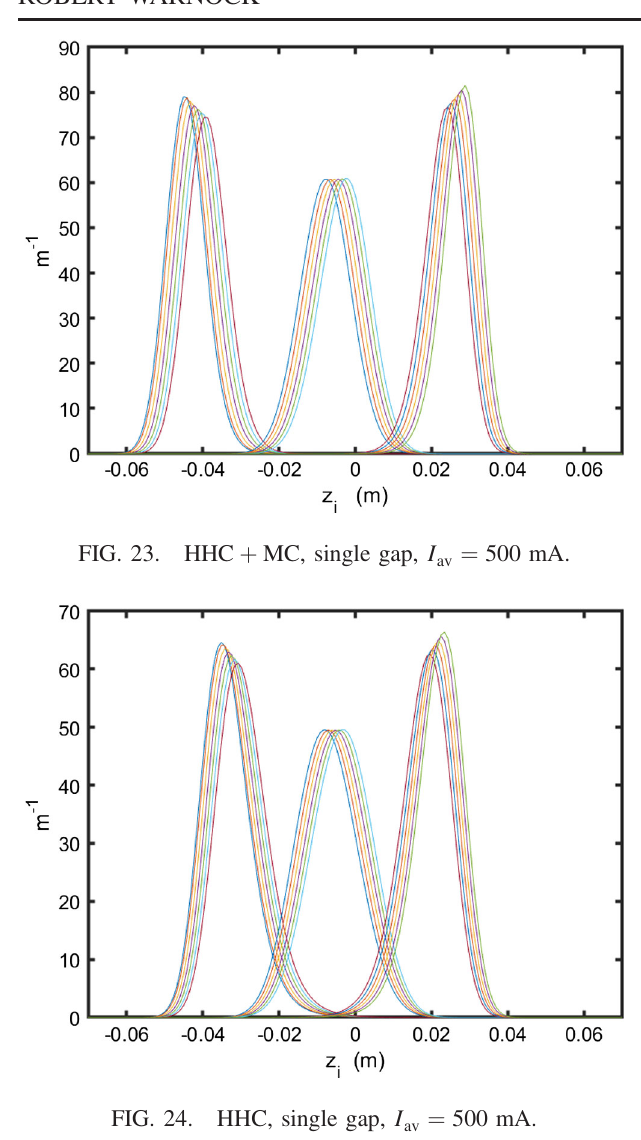
FIG. 24. HHC, single gap, I